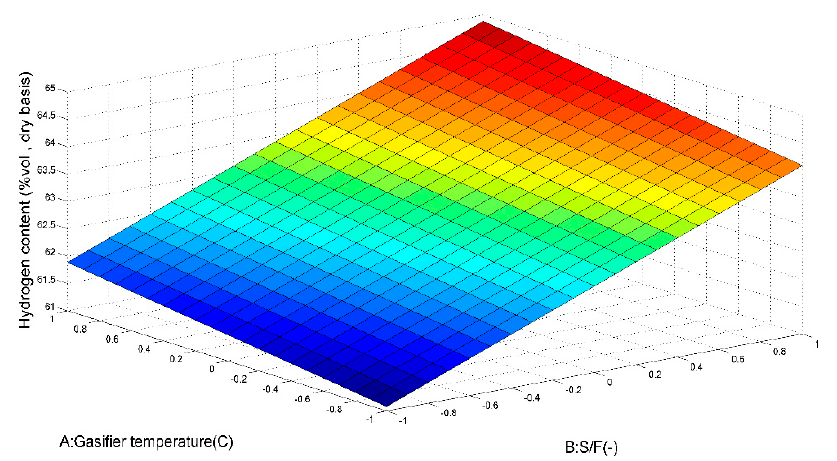
Figure 8. Response surface plot of H 2 content (%vol., dry basis) in the co-gasification process as a function of the gasifier temperature and S/F mass ratio.